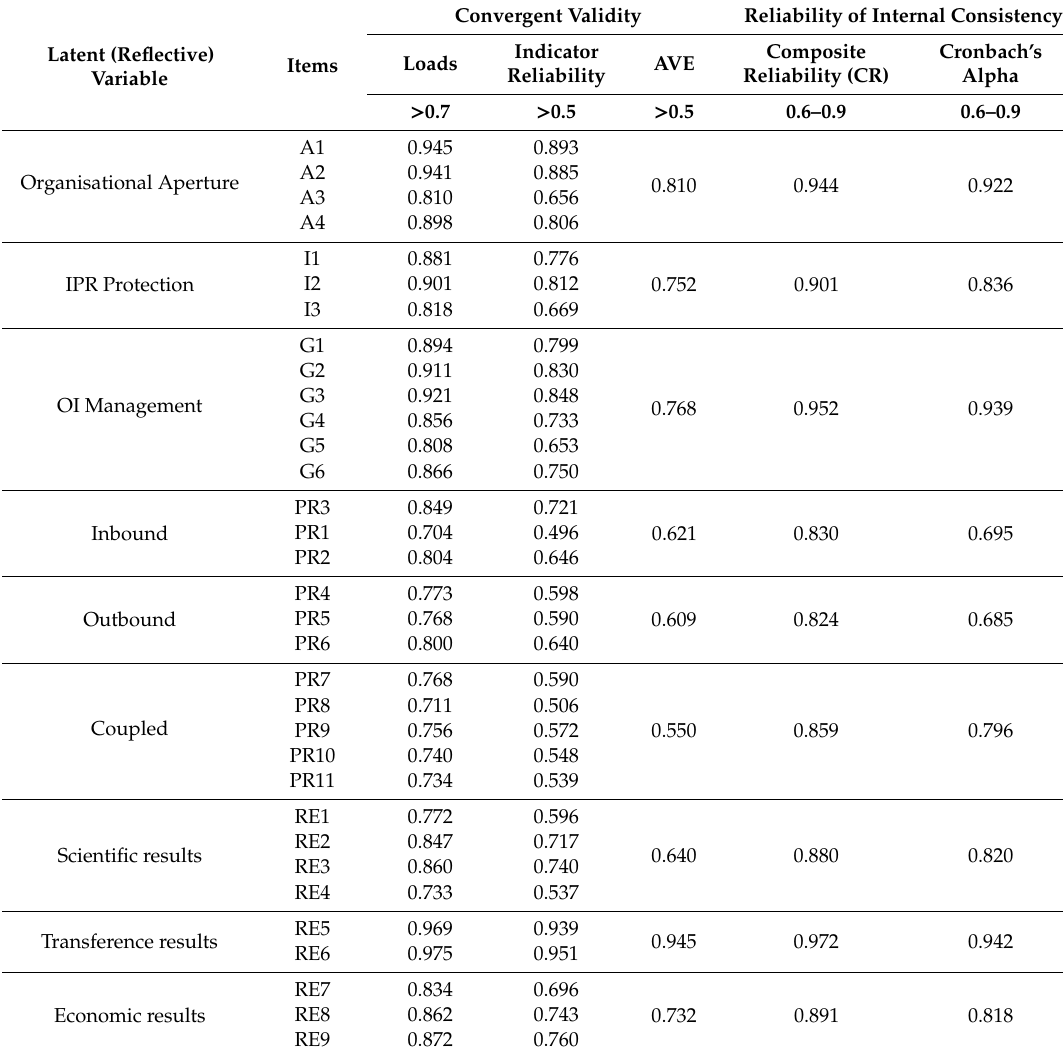
Table 5. Reliability and convergent validity of reflective